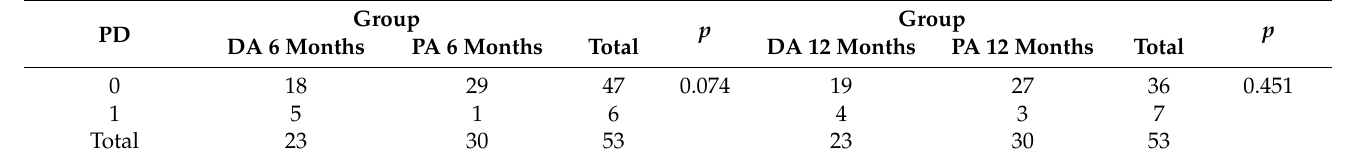
Table 5. Probing Depth, 6 and 12 months.